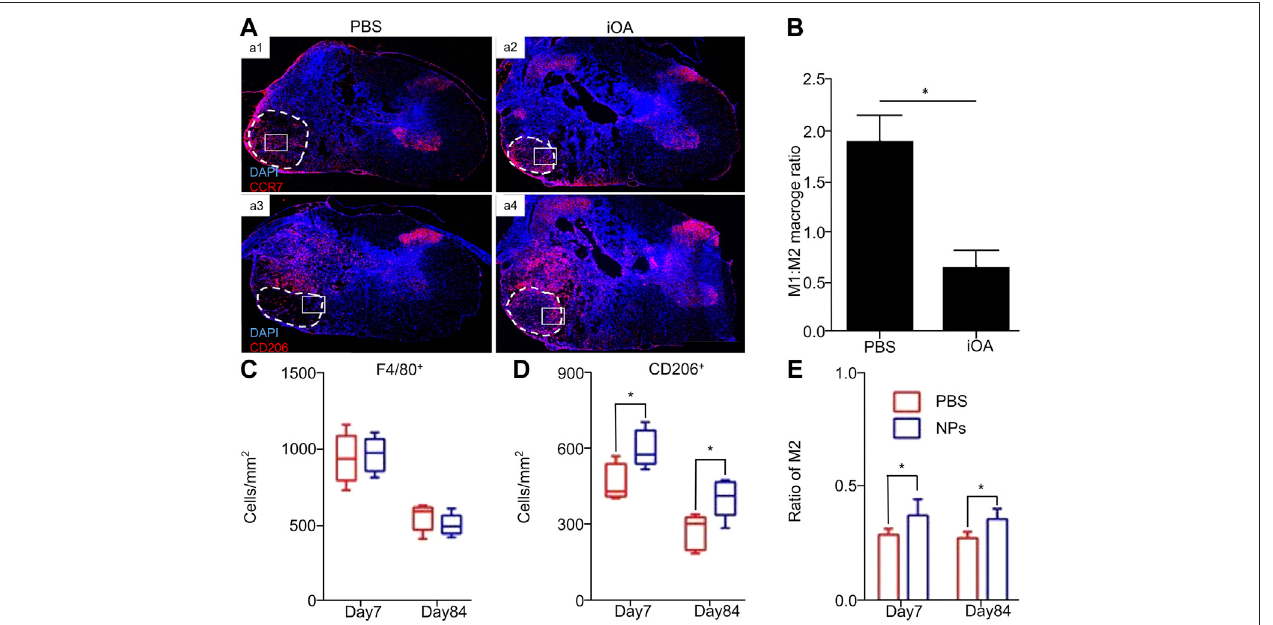
FIGURE 1 | Biomaterials directly regulate the polarization of macrophages/microglia. (A) The animals were treated with PBS (a1 and a3) and iOA hydrogel (a2 and a4) for 1 week, and the cross-section of the spinal cord was stained for macrophage markers. CCR7 is stained for M1 phenotype cells, and CD206 is stained for M2 phenotypecells. (B) TheratioofM1toM2phenotypiccellschangedfrom1.88±0.406forPBScontrolto0.635±0.085foriOA,athree-folddecrease (* p < 0.05;n=4). (C) ThedensityoftotalF4/80+macrophagesinthelesion. (D) QuantitativeanalysisshowedthatNPsup-regulatedtheexpressionofCD206+cells. (E) Theratioof M2 to the total number of macrophages was signi fi cantly up-regulated in the NP group. Reproduced with permission from (60,